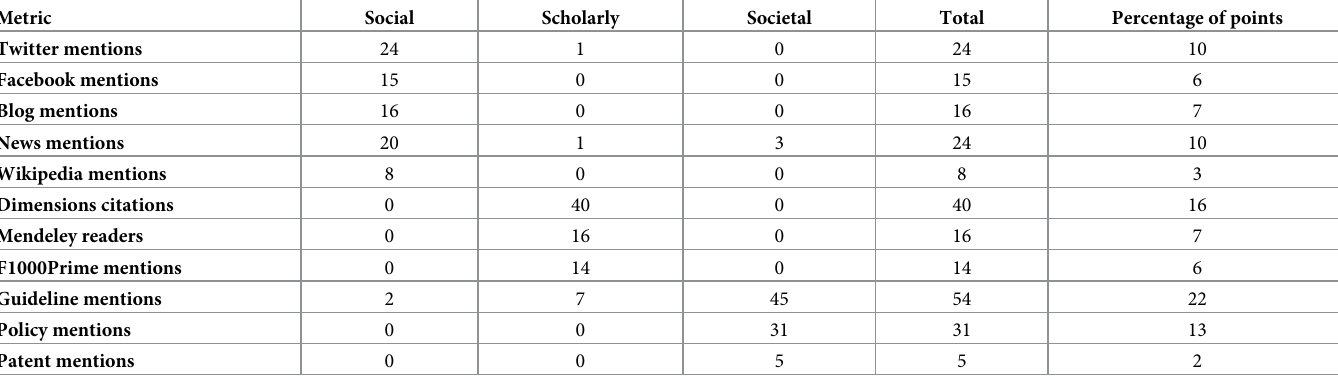
Table 1. Value accorded to metrics by the stakeholder panel (quantitative